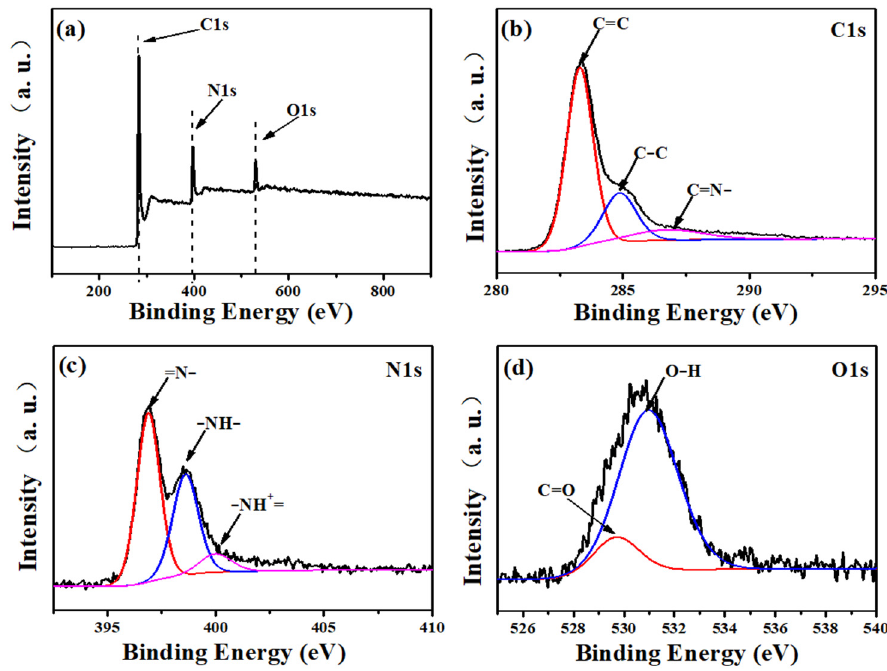
Figure 4. XPS spectra of C − 1: ( a ) the full survey spectrum, ( b ) C 1s, ( c ) N 1s, ( d ) O 1s.